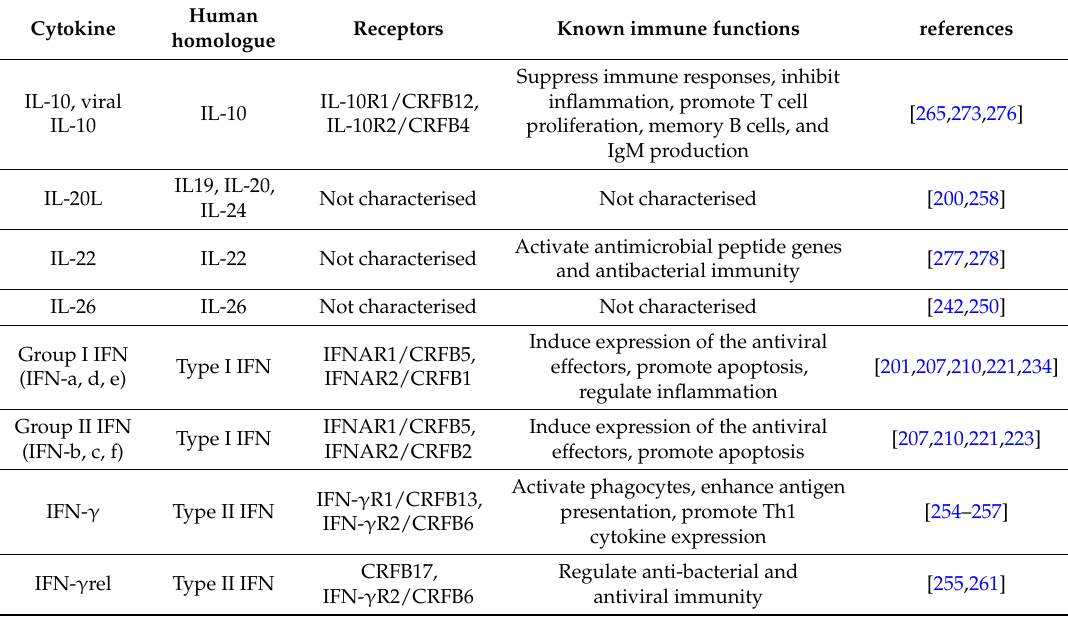
Table 1. Biological activity of fish type II